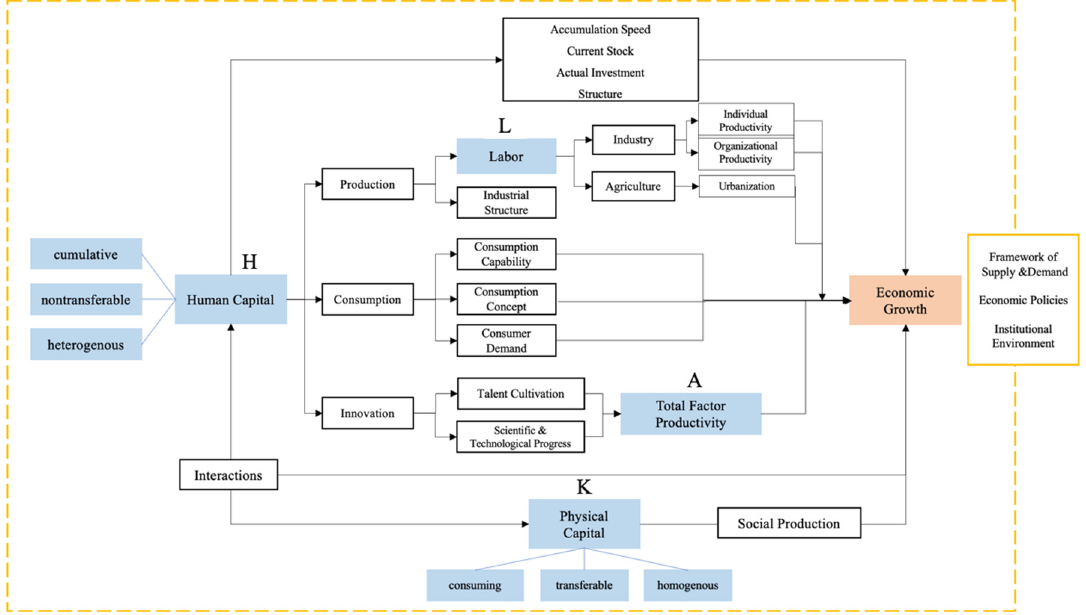
Figure 3. Influencing mechanism of human capital and physical capital promote economic growth.